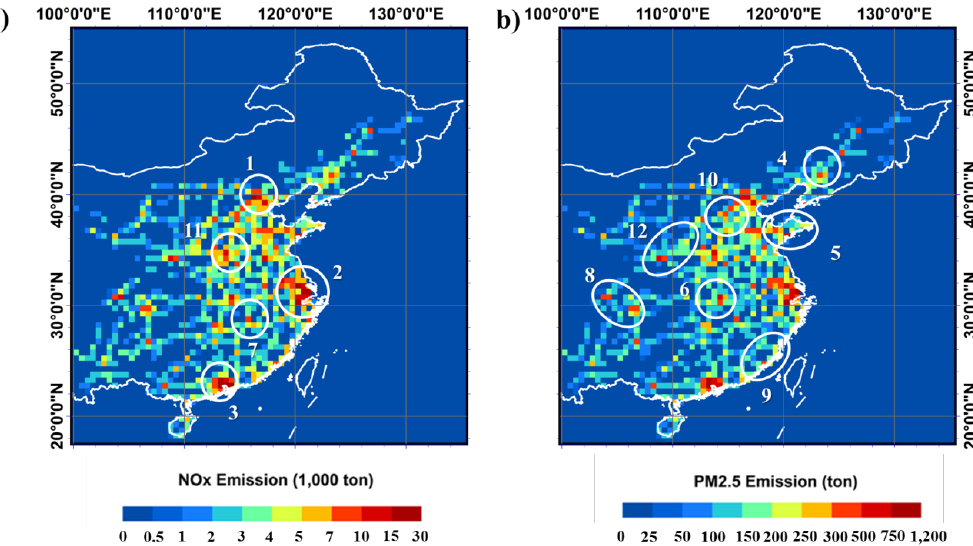
Figure 8. Maps of NO x and PM 2 . 5 emissions from freight trucks in the eastern part of China in 2011: (a) NO x emissions and (b) PM 2 . 5 emissions. Key control areas in 12th 5-year plan of air-pollution control: (1) Jing–Jin–Ji, (2) Yangtze River Delta, (3) Pearl River Delta, (4) central part of Liaoning province, (5) Shandong province, (6) Wuhan and its surroundings, (7) Changsha–Zhuzhou–Changde, (8) Chengdu and Chongqing, (9) west side of the Taiwan strait, (10) central and northern part of Shanxi province, (11) Guanzhong region in Shaanxi, (12) Gansu and